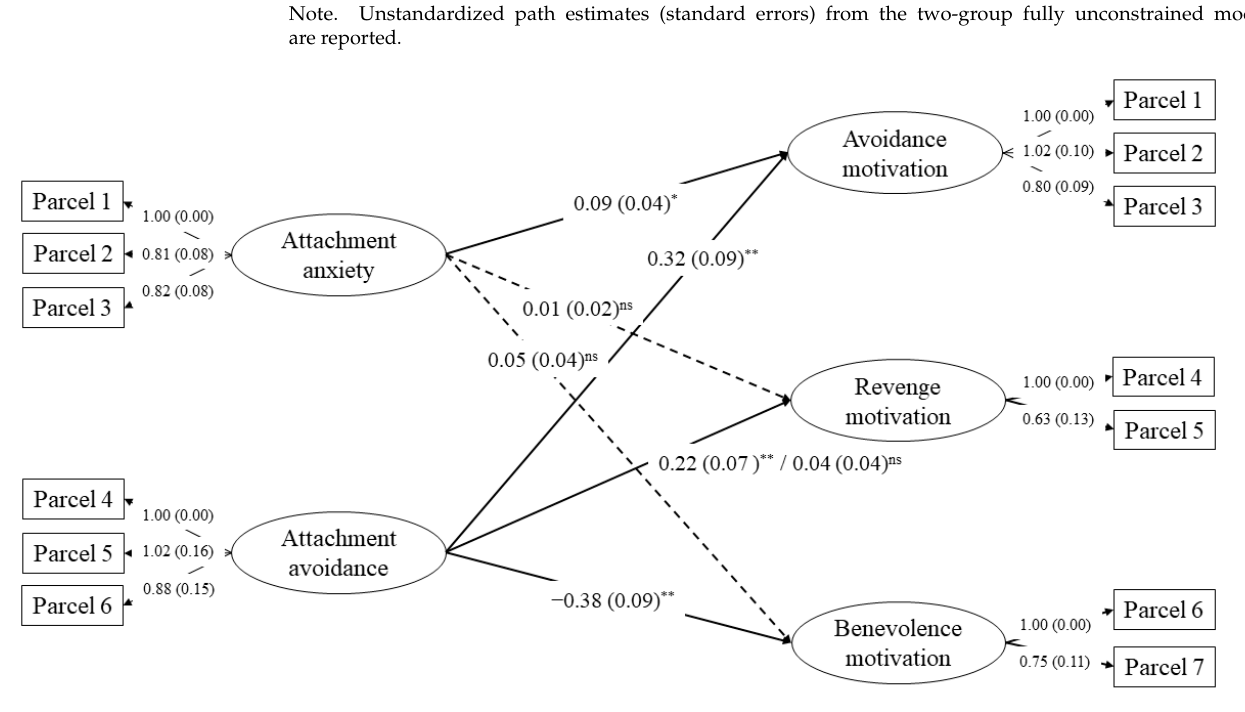
Table 4. Multigroup analyses on gender invariance of structural paths.